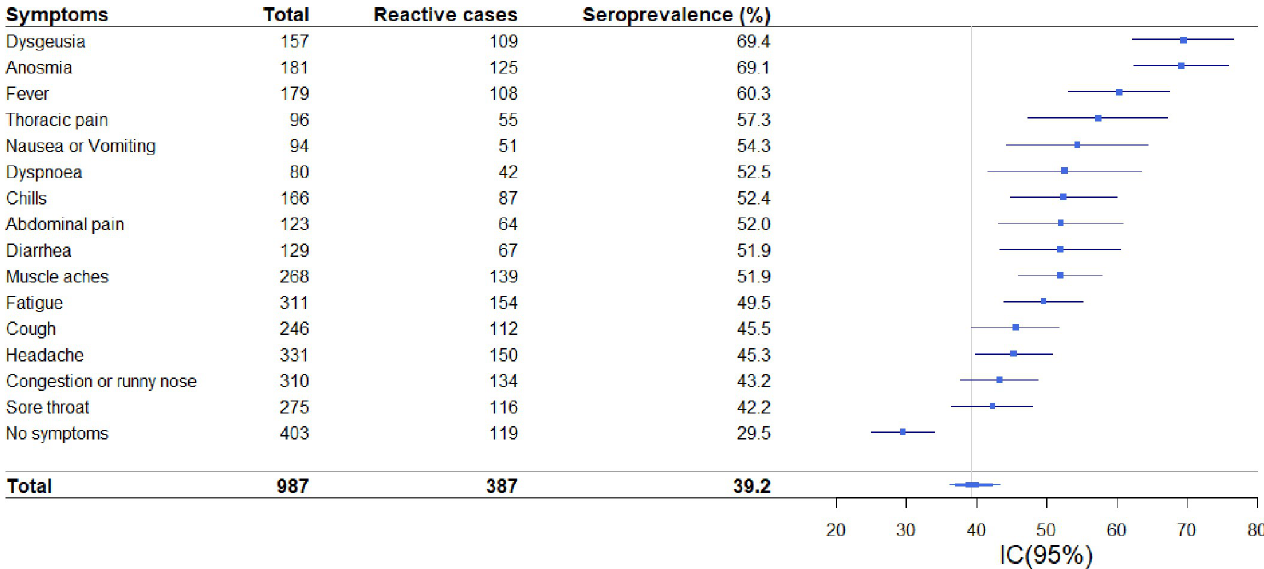
Fig 4. Forest diagram of SARS-CoV-2 seroprevalence according to reported symptoms. Puerto Madryn-Chubut, 2021. N = 987).